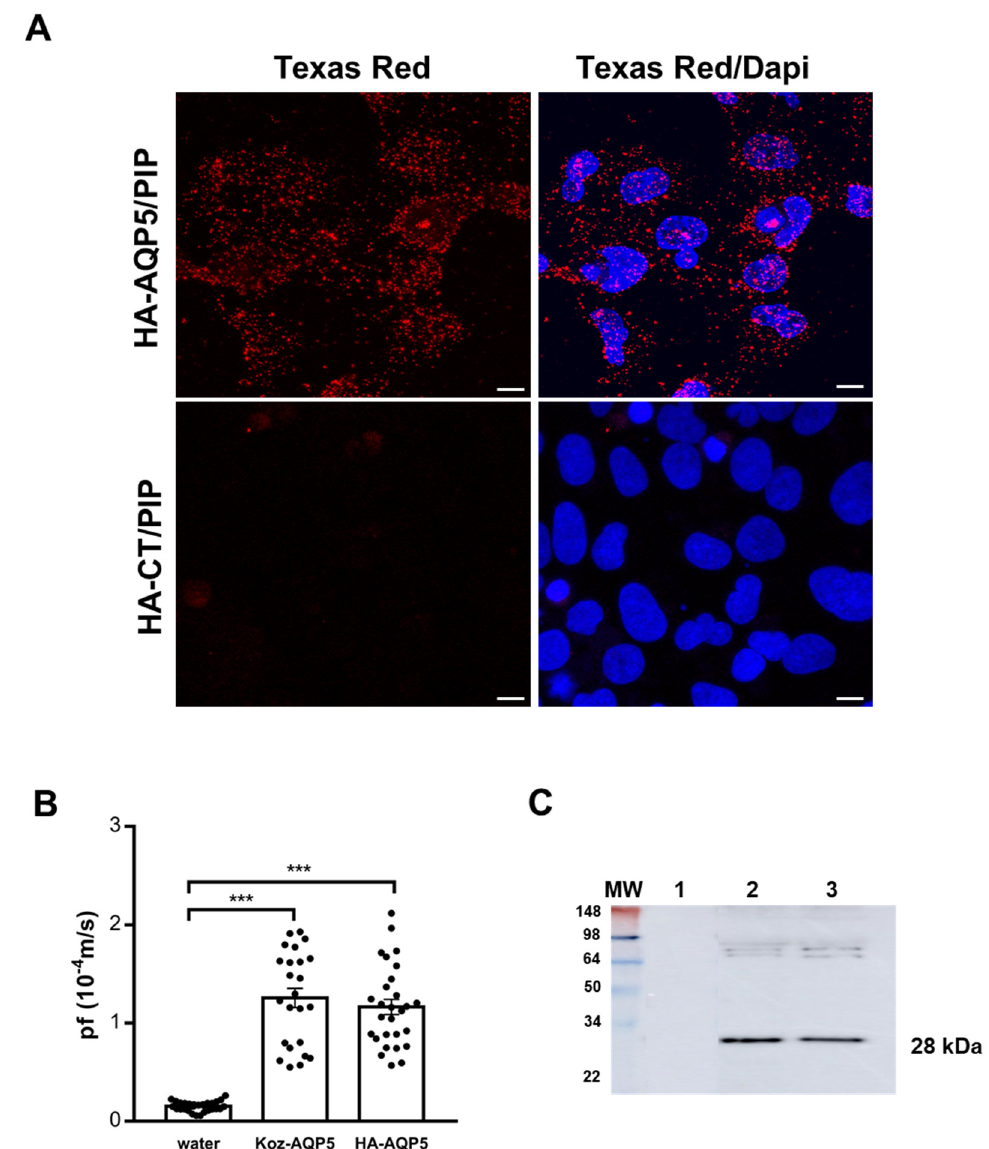
Figure 2. ( A ) PLA performed on transfected NS-SV-AC cells with HA-CT and PIP and HA-AQP5 and PIP. Nuclei were labeled with DAPI (blue) and AQP5-PIP interactions are in red (Texas Red). Scale bar, 10 µ m. Negative controls are shown in Appendix A, Figure A1, left. Images are representative of 3 experiments. ( B ) Xenopus laevis oocytes swelling assay. Results are the mean ± S.E.M. (n = 29 for water; n = 24 for Koz-AQP5; n = 28 for HA-AQP5). Statistical analysis was performed using One-way ANOVA; ***: p < 0.001. ( C ) The expression of AQP5 was verified by WB in the injected oocytes.